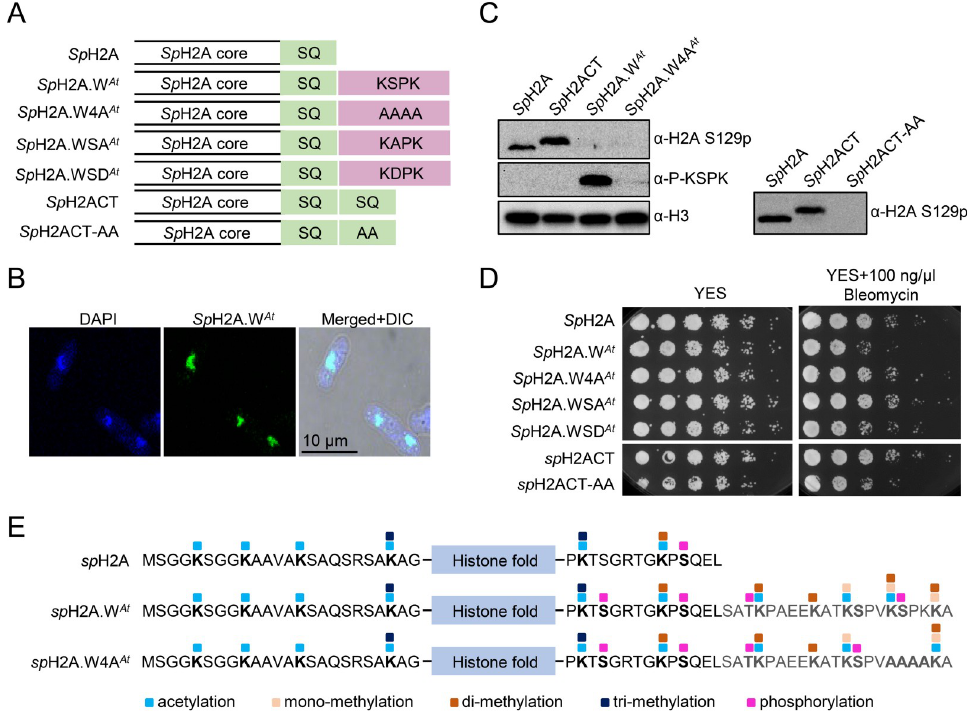
Fig 5. Phosphorylation of the KSPK motifs results in DNA damage sensitivity in yeast. (A) Schematic diagrams of fission yeast histone H2A ( Sp H2A) and mosaic versions containing either a duplicated C-terminal tail ( Sp H2ACT) or the C-terminal tail from Arabidopsis H2A.W.6 ( Sp H2A.W At ). Mutant versions in the SQ and KSPK motifs of the latter two constructs, Sp H2ACT-AA and Sp H2A.W4A At , are also depicted. (B) Sp H2A.W At localizes to the nucleus in fission yeast. Confocal images of immunostained cells from exponential phase are shown. 4 0 ,6-diamidino-2-phenylindole (DAPI) staining was used to visualize nuclei and differential interference contrast (DIC) for cell shape. (C) Analysis of Sp H2A S129 (SQ) and of Sp H2A.W At (KSPK) phosphorylation in indicated yeast strains. Cells were collected during exponential growth and whole cell extracts were analyzed with the indicated antibodies, using anti-histone H3 antibody as loading control. The lack of SQ phosphorylation signal in strains expressing Sp H2A.W At , Sp H2A.W4A At , and Sp H2ACT-AA is due to the inability of the antibody to bind to the epitope. Phosphorylation of the SQ motif in these strains was confirmed by mass spectrometry (S5D Fig). (D) Phosphorylation of Sp H2A.W At at the KSPK motif confers sensitivity to DNA damage. Serial dilutions of fission yeast cells expressing WT and indicated Sp H2A mosaic variants were spotted onto either YES or YES plates containing 100 ng/ μ l Bleomycin and incubated at 32˚C for 3 days. (E) Summary of all PTMs detected on Sp H2A in WT and chimeric histone in indicated yeast strains. Amino acid sequence of N- and C-terminal tails of chimeric histone are indicated with the conserved Sp H2A SQ motif and H2A.W.6 KSPK motif respectively. The blue box indicates the histone fold domain. Post-translational modifications detected by MS are color-coded as indicated at the